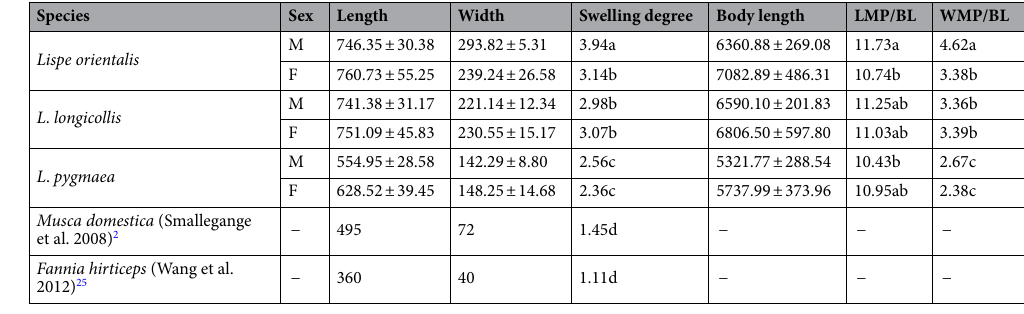
Table 1. Length, width, swelling degree (10 –1 × width/length) of maxillary palps, body length and the ratio of length and width of maxillary palps to body length (10 –2 × LMP/BL and 10 –2 × WMP/BL) in three Lispe species, Musca domestica , and Fannia hirticeps (μm ± SD, n = 5). M male, F female, BL body length, LMP length of maxillary palp, WMP width of maxillary palp, − undetermined. Different lower-case letters on swelling degree data mean statistically significantly different (P < 0.05, n =